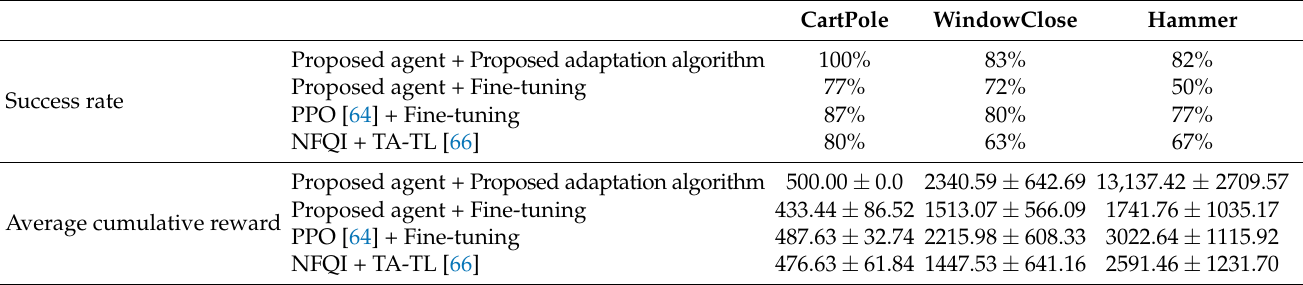
Table 4. The performance of the proposed agent on target tasks after adaptation. CartPole WindowClose Hammer